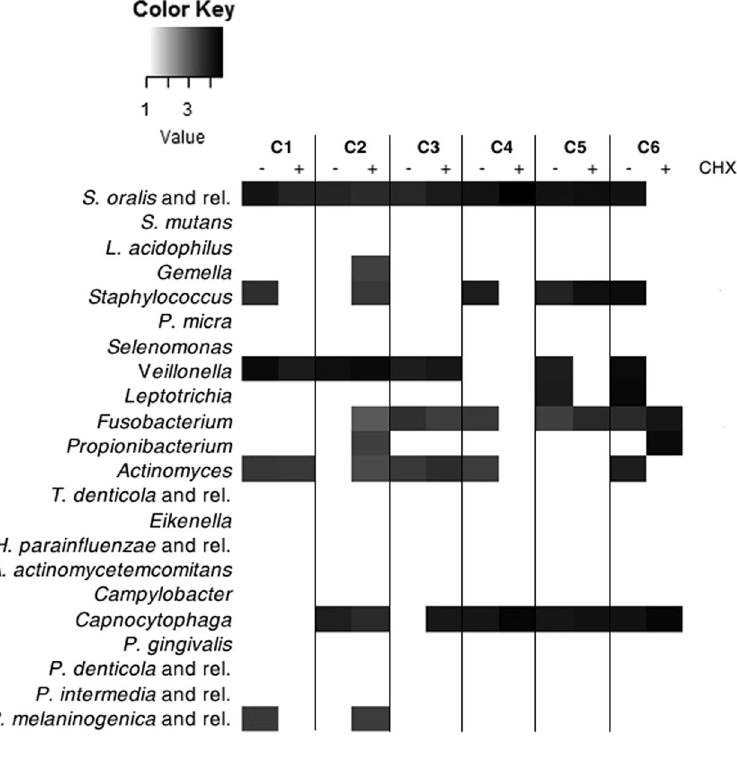
Figure 6. Heatmap of the OralArray data of control and chlorhexidine treated healing caps. Control and chlorhexidine-treated healing caps were put on the implants for two weeks, then collected, and bacterial signature depicted by OralArray. Fluorescence intensities (IFs) were normalized over the IFs of the Zip Code 63, as described in the Methods section. The mean values of the logarithm of IFs (n = 4) for each bacterial target are plotted in a scale of grey, by using R “made4” package. C1-C6 referred to healing cap pairs. CHX: